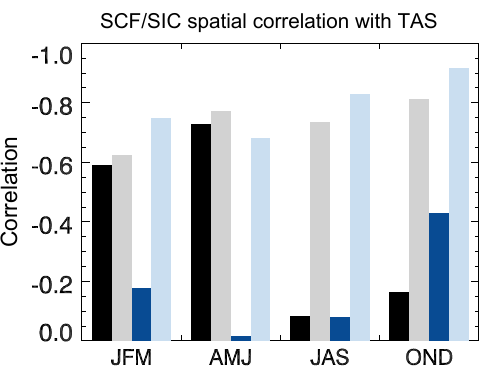
Figure 3. Centred (dark) or uncentred (light) pattern correlation be- tween seasonal TAS trends and seasonal SCF (black) or SIC (blue) trends.